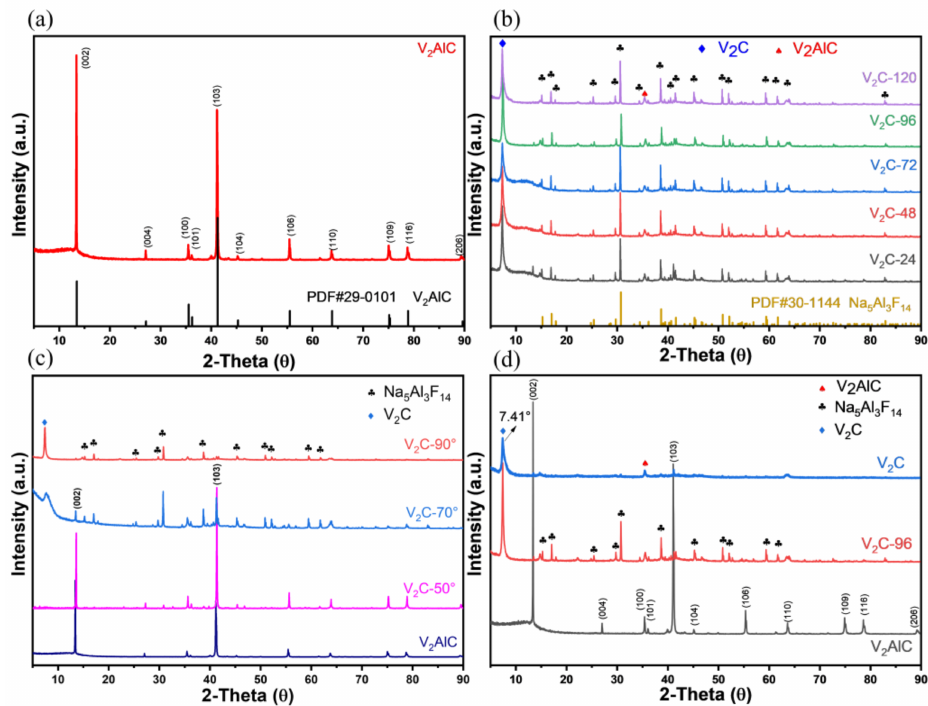
Figure 2. XRD spectra of ( a ) V 2 AlC, ( b ) samples with different reaction time, ( c ) samples with different reaction temperatures, ( d ) V 2 C before and after